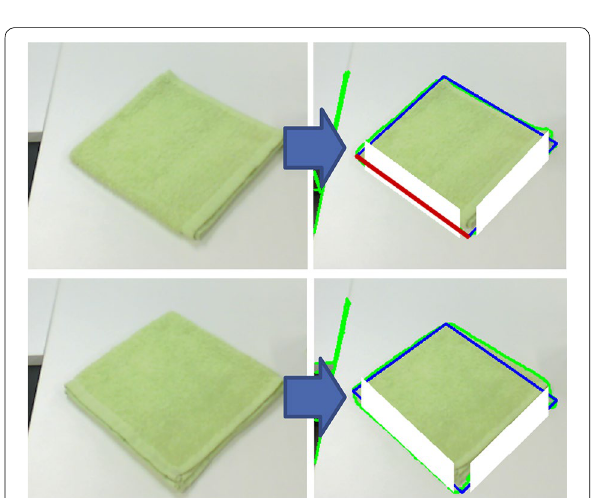
Fig. 10 Results of the thickest hem detection in a case where two hems are visible on the near